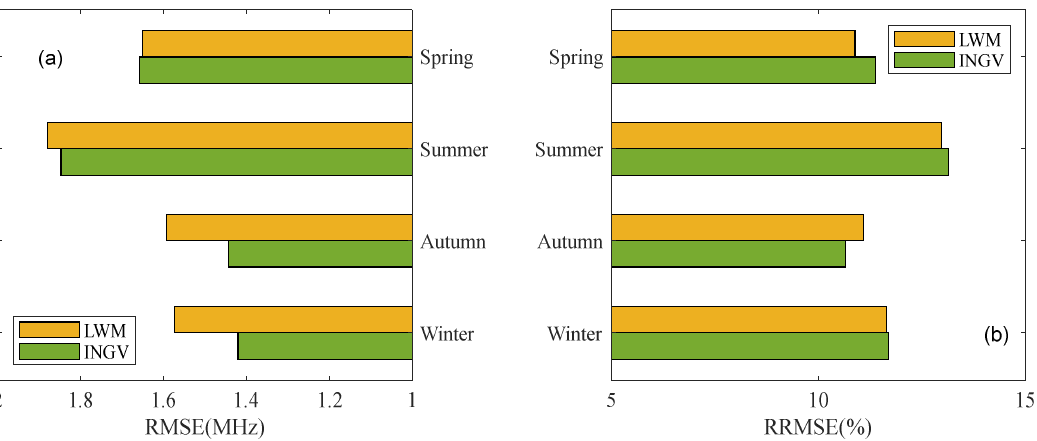
Figure 6. The seasonal behavior of MUF calculated by the LWM and INGV: ( a ) RMSE; ( b ) RRMSE.